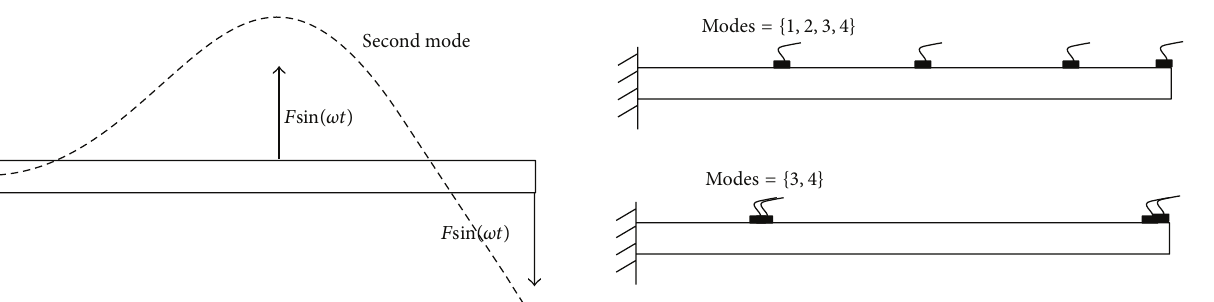
Figure 5: Different result for measurement locations of 4 sensors (a) if modes 1 to 4 are important and (b) if only modes 3 and 4 are important for the dynamic